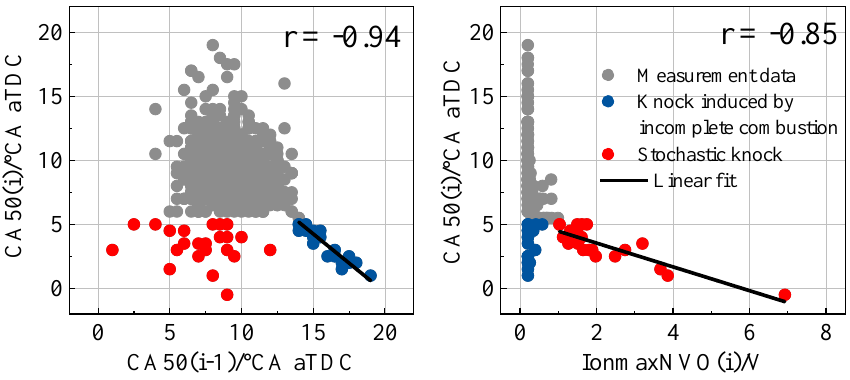
Figure 9. Judgment basis for two kinds of knock.